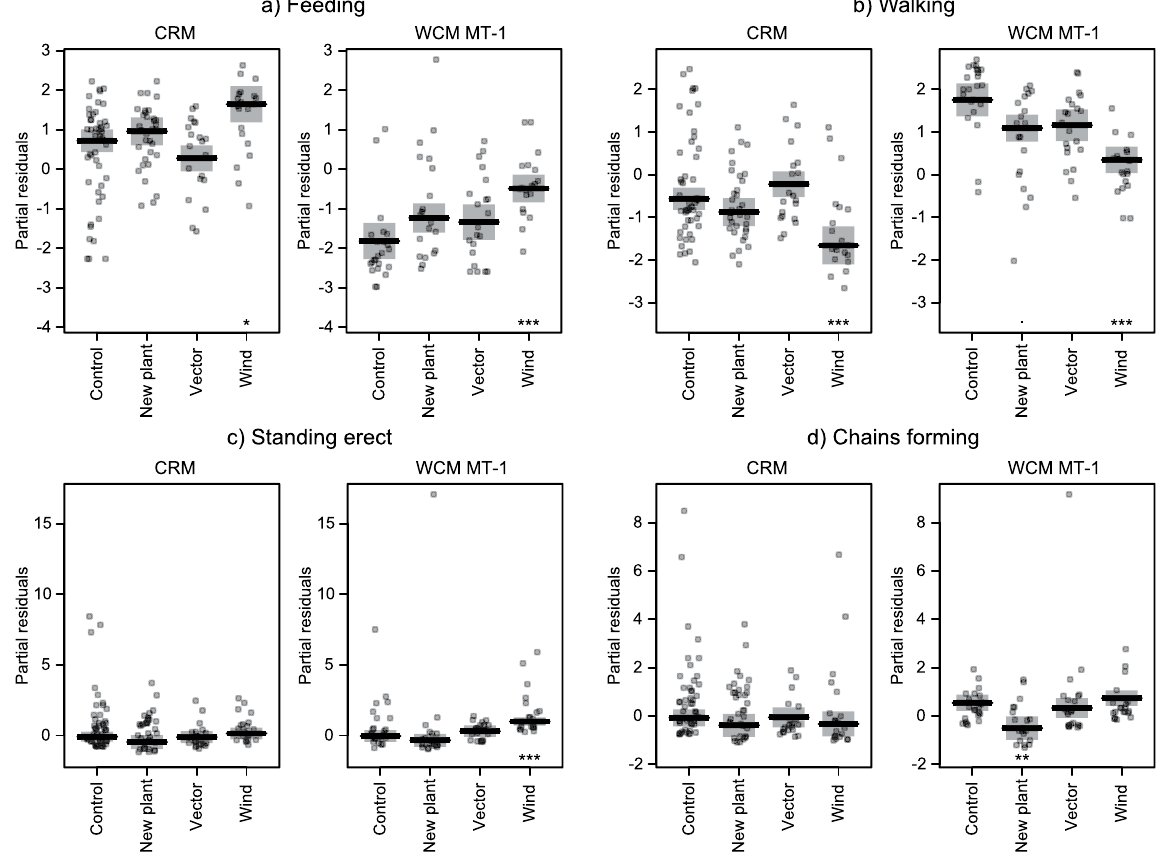
Figure 2. Results of Simultaneous Tests for General Linear Hypotheses. Effects of potential dispersal cues on the proportion of mites displaying particular behaviours (feeding, walking, standing erect, chain formation) when comparing to the control for the two species of eriophyid mites. Values on vertical axes are partial residuals. Significance codes: *** p < 0.001; ** p < 0.01; * p < 0.05; · p < 0.1. Exact p values can be found in Supplementary Table